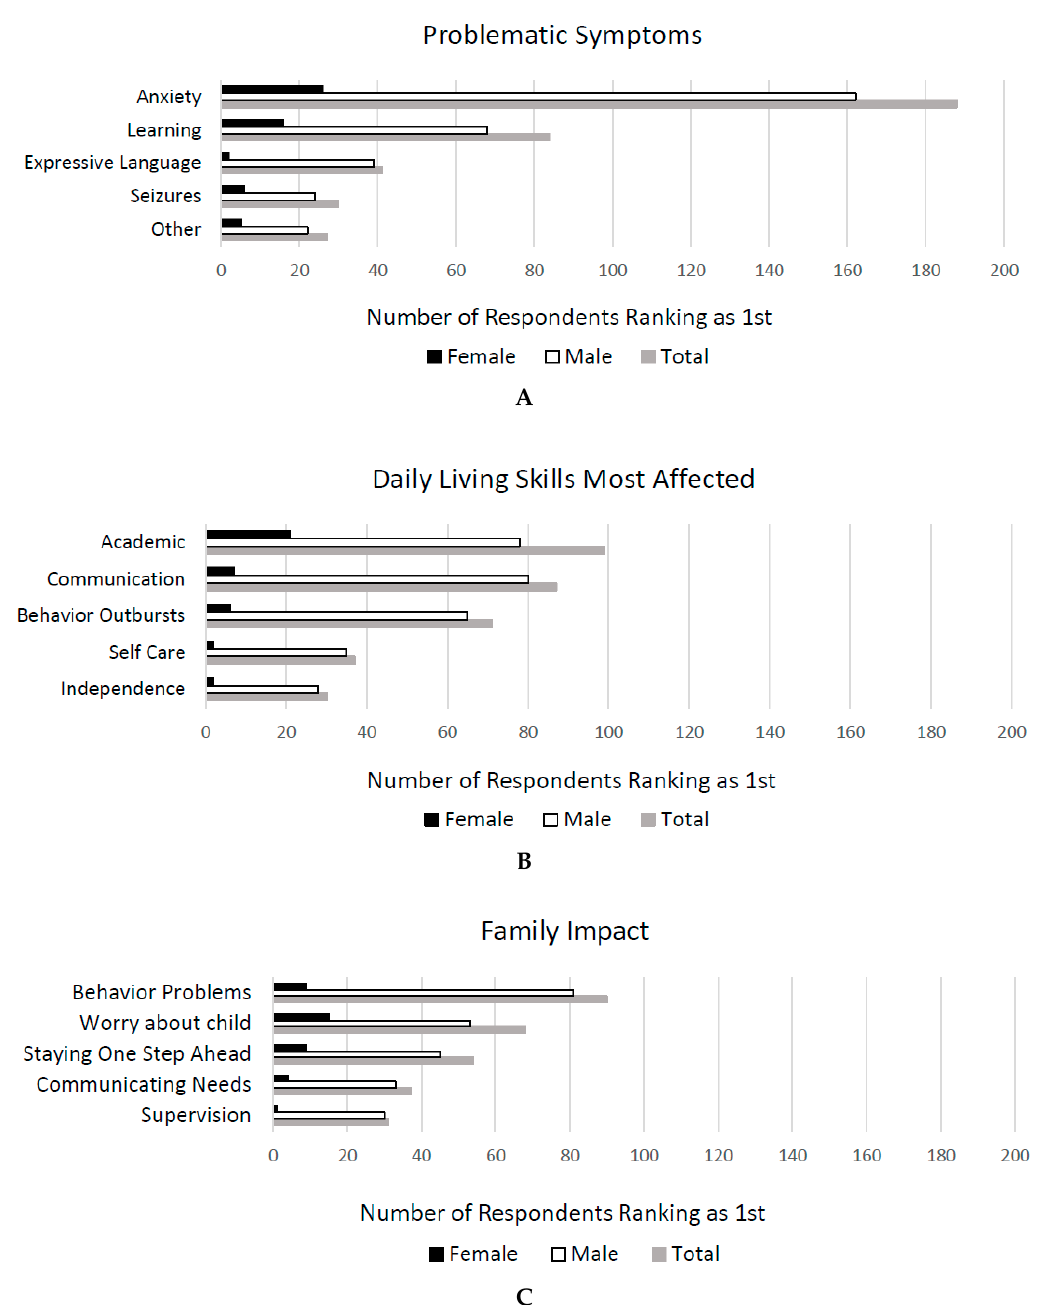
Figure 3. Family member/caretaker’s 1st rank for characteristics that have the greatest impact on the